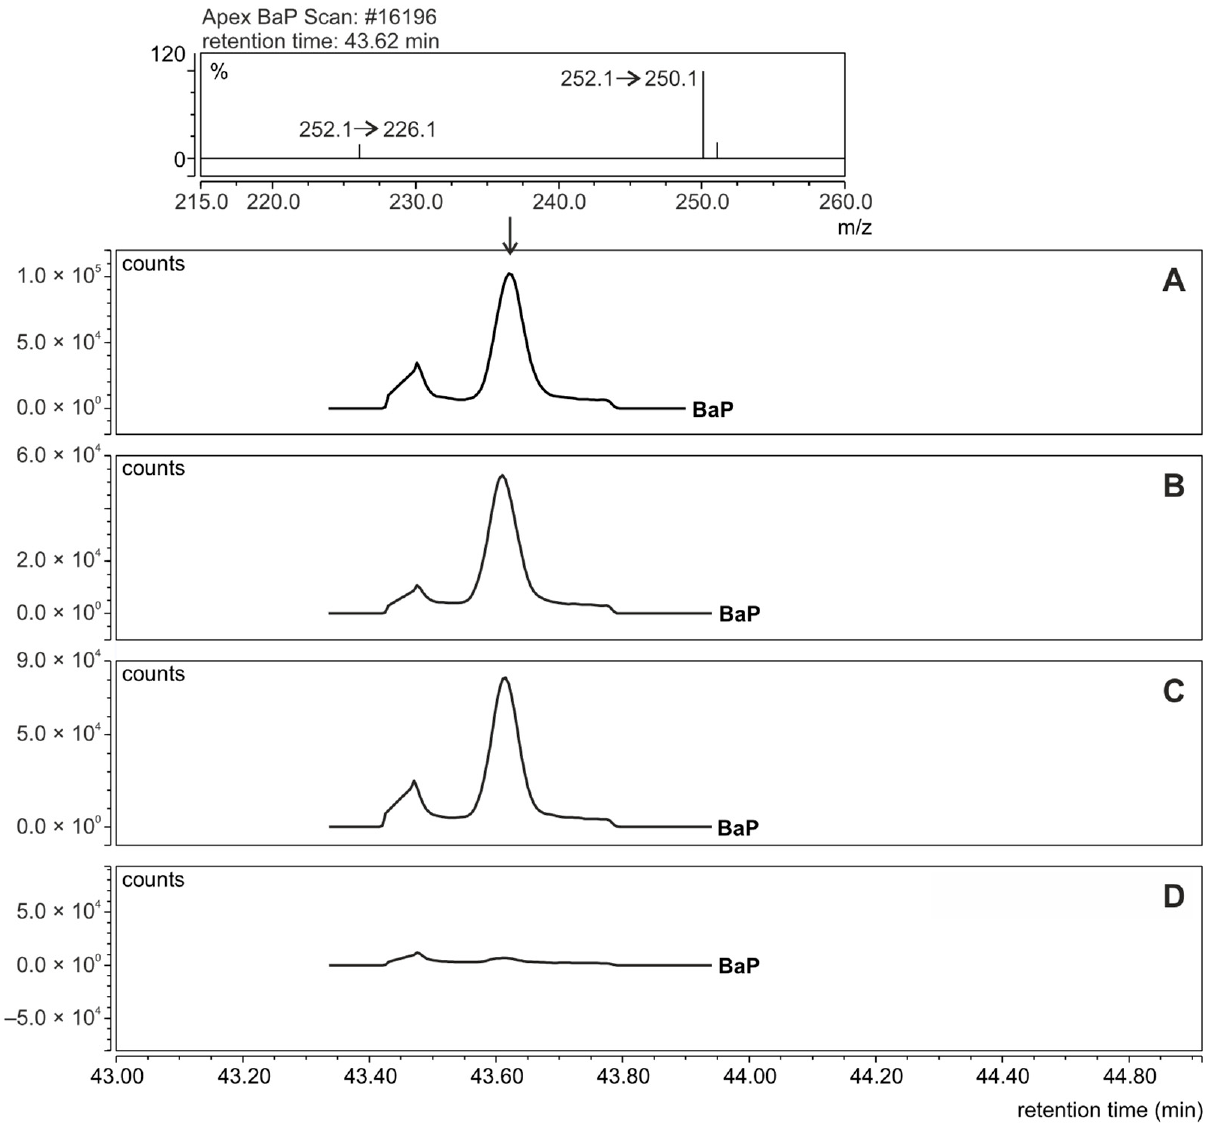
Figure 3. GC-MS/MS chromatograms recorded in selective reaction monitoring (SRM) mode for the detection of BaP in fractions isolated from meat samples. ( A ): Control sample (pork meat prepared without additives); ( B ): pork meat with prunes; ( C ): with apricots; ( D ): with cranberries. The chromatograms corresponds to the fragmentation reaction of the precursor ion ( m/z = 252.1) to the product ion ( m/z 250.1). The collision energy for this reaction was 35 eV.